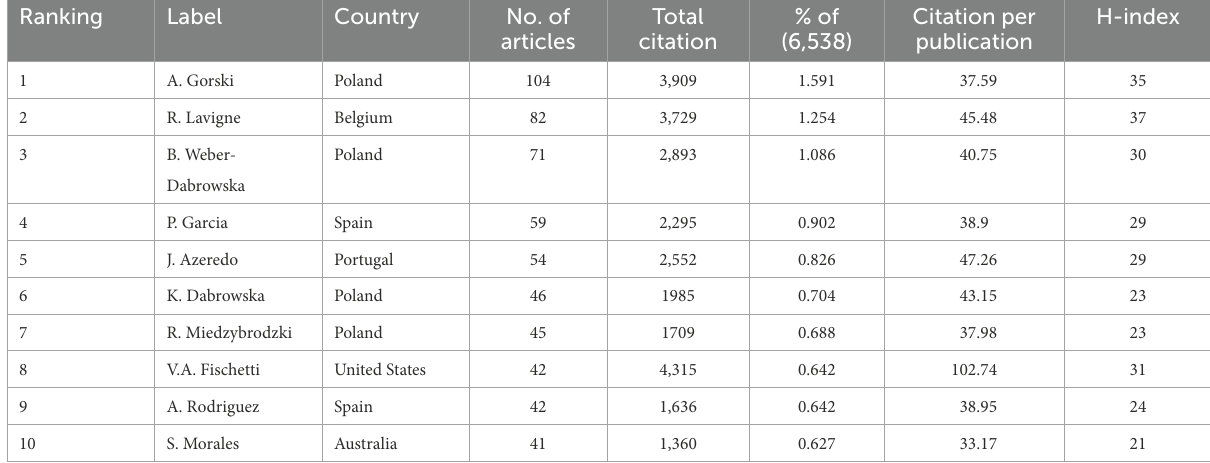
TABLE 5 Top 10 authors related to phage therapy in bacterial infection. Ranking Label Country No. of